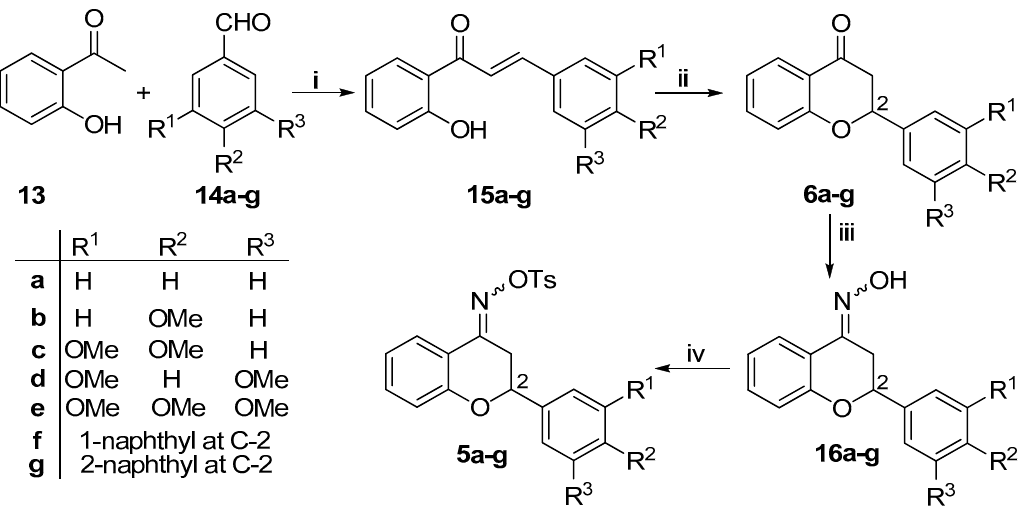
Table 1. Yields of the products obtained in the Neber reaction of 5a - g . i: (1) NaOEt, dry toluene, rt,